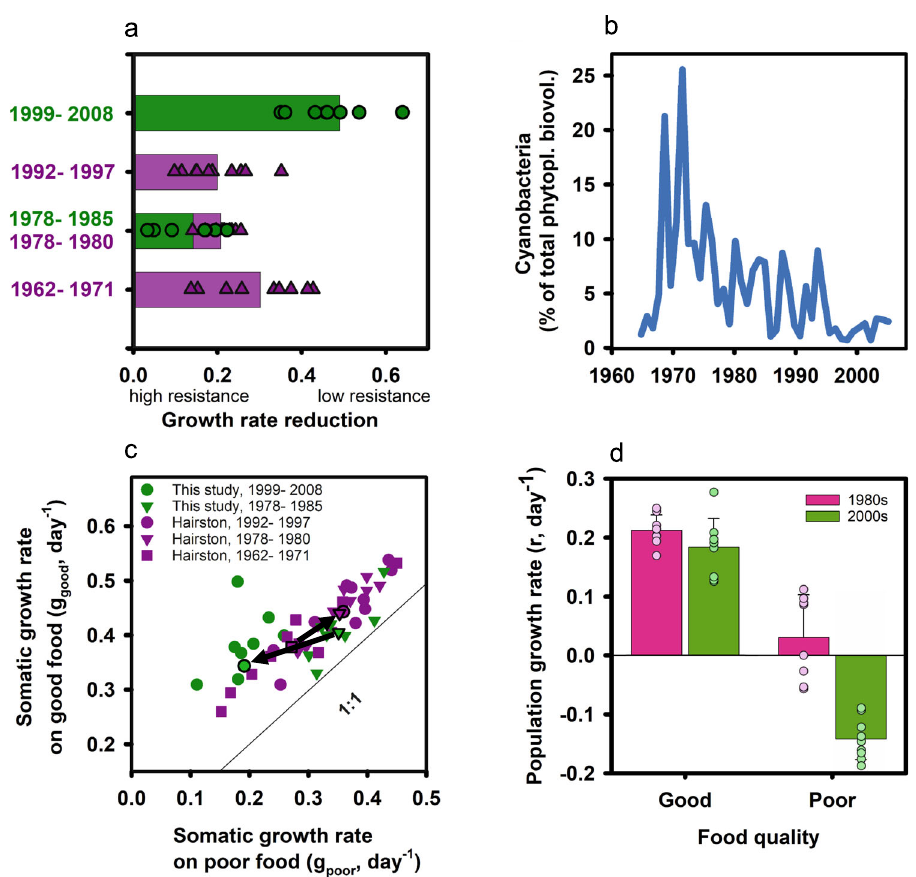
Fig. 1 Performance of Daphnia genotypes and cyanobacteria biomass. a Resistance of Daphnia genotypes to toxic cyanobacteria. Single data points depict average (i = 3) growth rate reduction (GRR) for individual genotypes, bars show the average GRR of all genotypes within a single time period (green dots and bars; high GRR = low resistance; one-way ANOVA, F 1,16 = 62.6, p < 0.001). For comparison, data from Hairston et al. 12 (purple triangles and bars) are included, showing the rapid adaptive evolution of Daphnia genotypes to dietary cyanobacteria. b Contribution of cyanobacteria to total phytoplankton biovolume (blue line) in Lake Constance 43 . c Growth rate on good food always exceeded that on poor food. Average juvenile somatic growth rates of genotypes from fi ve-time periods are depicted in purple (Hairston et al. 12 ) and green (this study) symbols. Mean juvenile growth rates (symbols with black outline) of the different time zones are connected with black arrows, the trajectories of evolution are opposed (black arrows). Evolution of mean juvenile growth rate moved parallel to the 1:1 line from 1960s to 1990s but away from the 1:1 line from 1980 to 2000s (reversed evolution of grazer resistance during oligotrophication). d Per capita population growth rates (r) of genotypes from the 1980s (pink bars and symbols; n = 8 biologically independent genotypes) and 2000s (green bars and symbols; n = 9 biologically independent genotypes) on good and poor food. Bars represent mean values and standard deviation, single data points depict average population growth rate of one genotype. On poor food, none of the genotypes from 2000s was able to reproduce, while fi ve out of eight genotypes from 1980s were able to produce three consecutive clutches with viable offspring. For genotypes that did not produce any offspring on poor quality food, population growth rates re fl ect the per capita death rates (see methods). Population growth rates differed signi fi cantly between the two time periods on the poor food ( p = <0.001) but not on the good food ( p = 0.241; Tukey ’ s HSD following two-way ANOVA: food: F 1,33 = 233.8, p < 0.001; time zone: F 1,33 = 36.5, p < 0.001; food × time zone: F 1,33 = 18.9, p < 0.001). Source data are provided as a Source Data fi